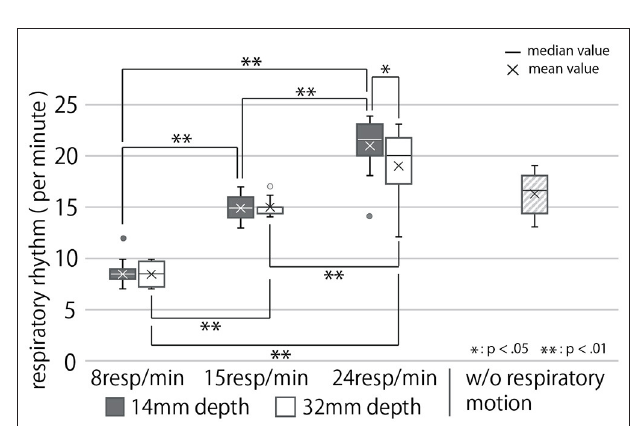
FIGURE 9 | Participants’ respiratory rhythm under each condition. Data more than 1.5 times the quartile range away from the quartile point are represented as